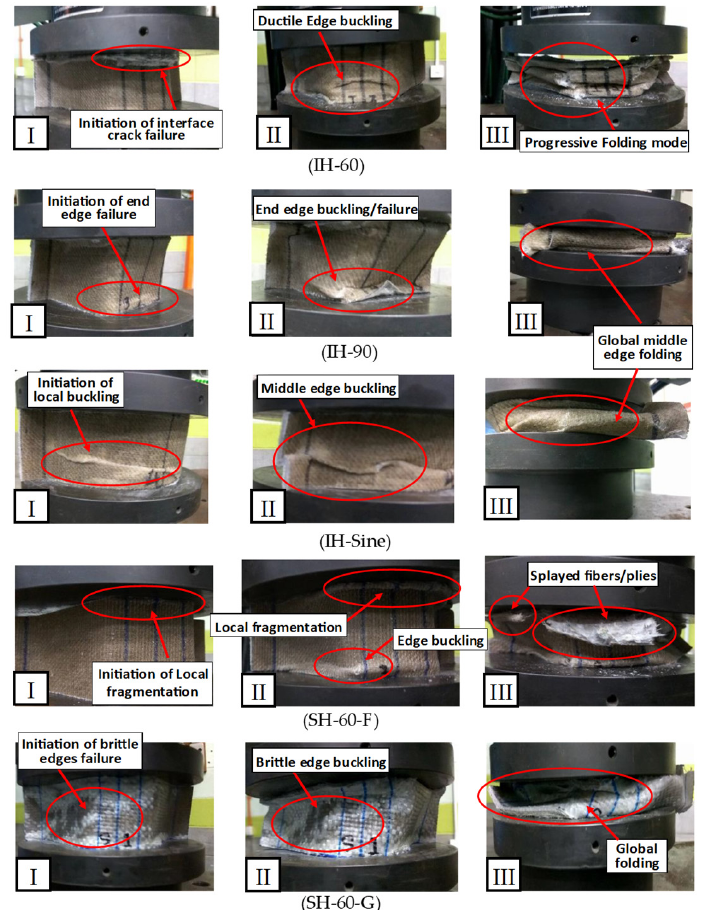
Figure 7. The crushing morphology at each stage of crushing (I: Zone I) (II: Zone II) (III: Zone III).